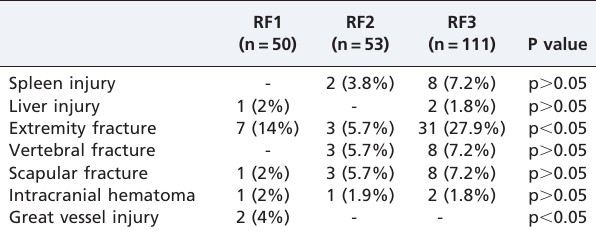
Table 3 - The distribution of co-existing injuries to other systems by